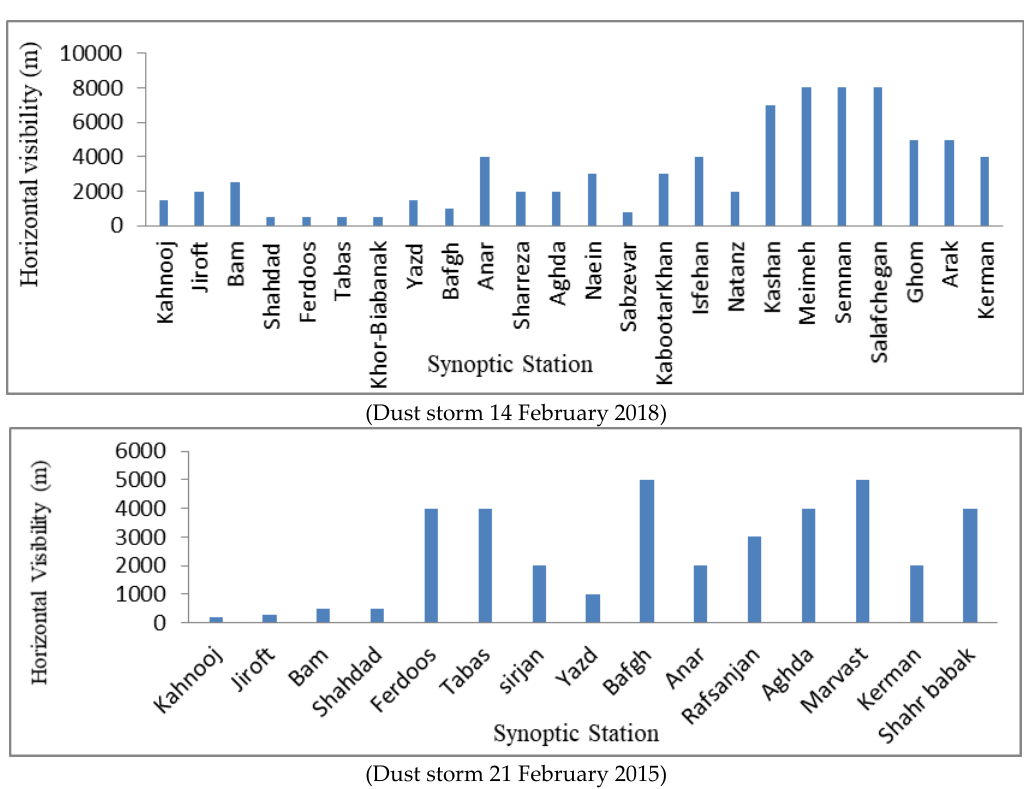
Figure 3. Horizontal visibility of some synoptic stations in the study area in the 14 February 2018 and 21 February 2015 storms.